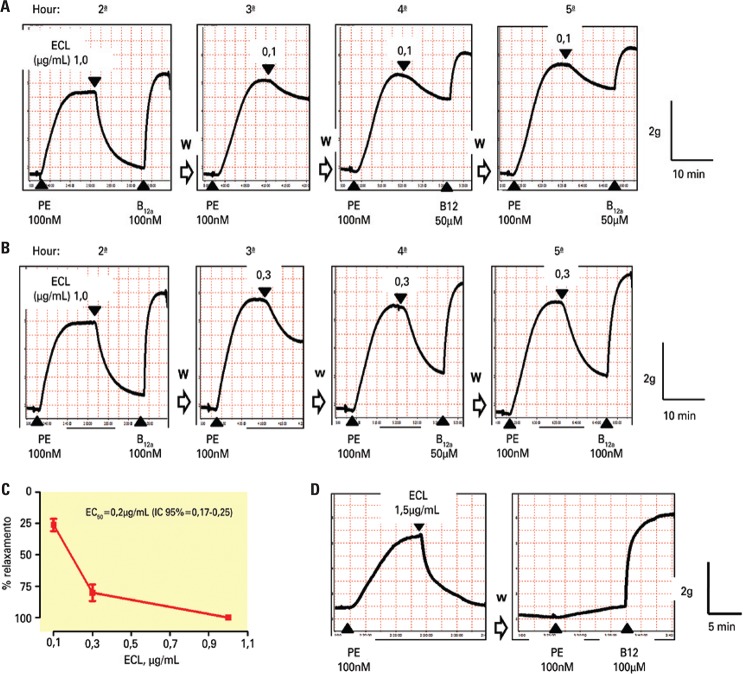
Traçados representativos mostrando o efeito de baixas concentrações de extrato de Combretum leprosum (ECL) sobre os anéis da aorta torácica de coelho pré-contraídos com fenilefrina (PE). As concentrações de ECL foram adicionadas de forma não cumulativa após a “ativação” das preparações com ECL (1,0µg/mL) (A), assim como a reversão do relaxamento induzido por ECL por hidroxocobalamina (B12a; 100µM). Pode-se observar que a magnitude do relaxamento induzido por ECL (0,1-0,3µg/mL) aumentou progressivamente com as adições sucessivas e se estabilizou somente após a quarta ou quinta hora (A e B). O painel C mostra a curva de concentração-efeito (valores médios ± erro padrão da média - EPM) observada após as 4 horas (**teste bicaudal p<0,0067, teste t pareado). Em D, um traçado representativo mostrando que a magnitude das contrações induzidas por PE permaneceu reduzida mesmo 1 hora após a remoção do ECL (1,5µg/mL) da cuba e a recuperação da contração por meio da adição de B12a. L: lavagem da preparação por 60 a 45 minutos; EC50: metade do relaxamento máximo; IC95%: intervalo de confiança de 95%